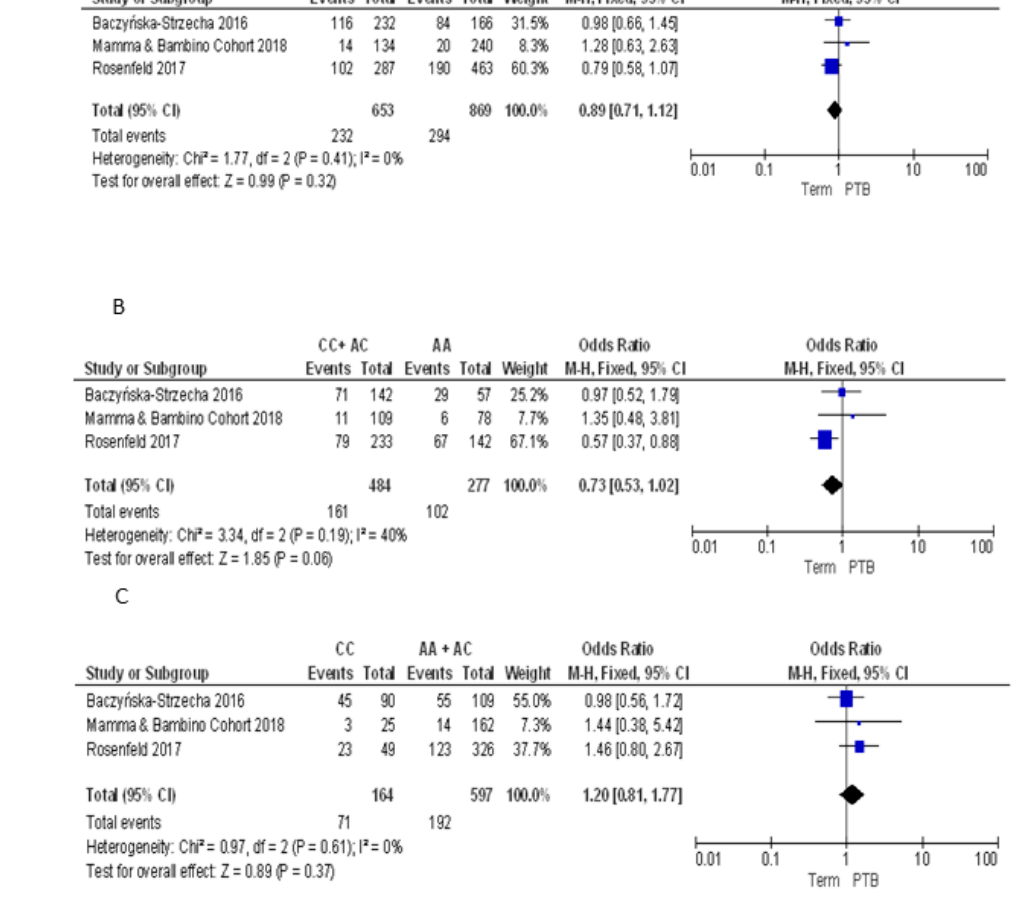
Figure 3. Forest plots of the association between ApaI polymorphism and preterm birth under the ( A ) allelic, ( B ) dominant and ( C ) recessive models.